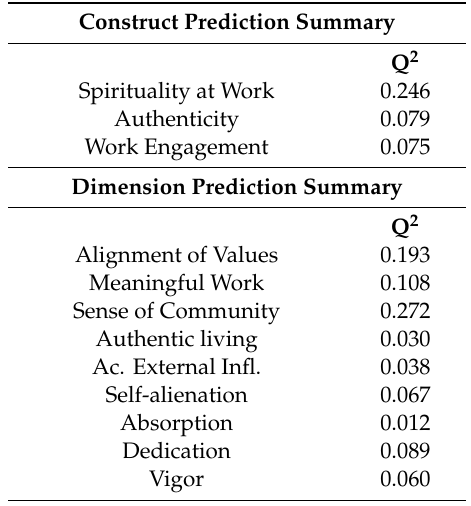
Table 6. Partial least squares prediction